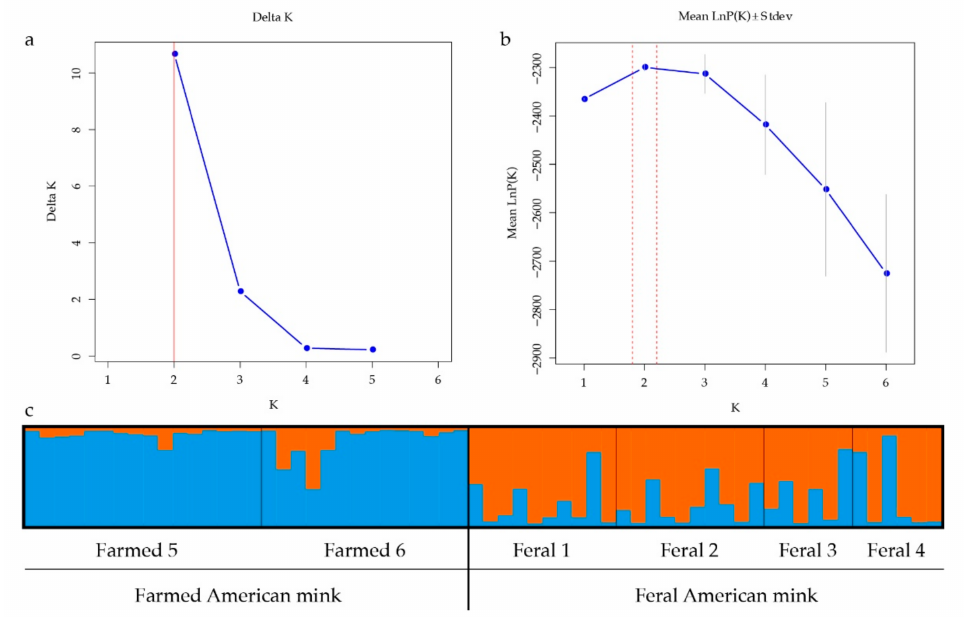
Figure 2. STRUCTURE clustering results deduced from microsatellite alleles within populations of American mink. ( a , b ) ∆ K and Ln P ( X / K ) values as a function of the K values according to 10 run outputs; ( c ) STRUCTURE clustering results at K = 2, with different colours representing different clusters, deduced from microsatellite alleles within farmed and feral populations of American mink.